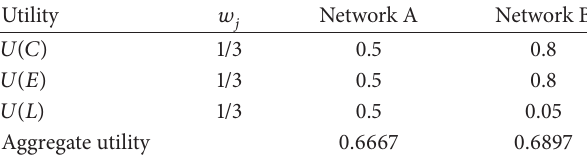
Table 3: Network selection based on GRA.